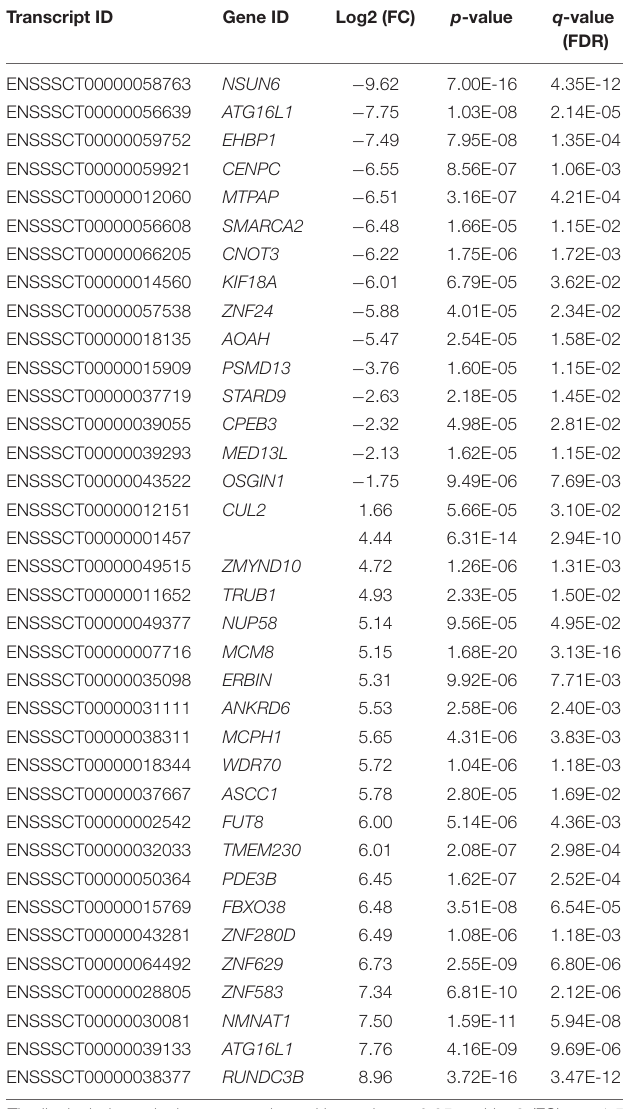
TABLE 3 | Messenger RNA transcripts showing differential abundances in the summer versus the winter